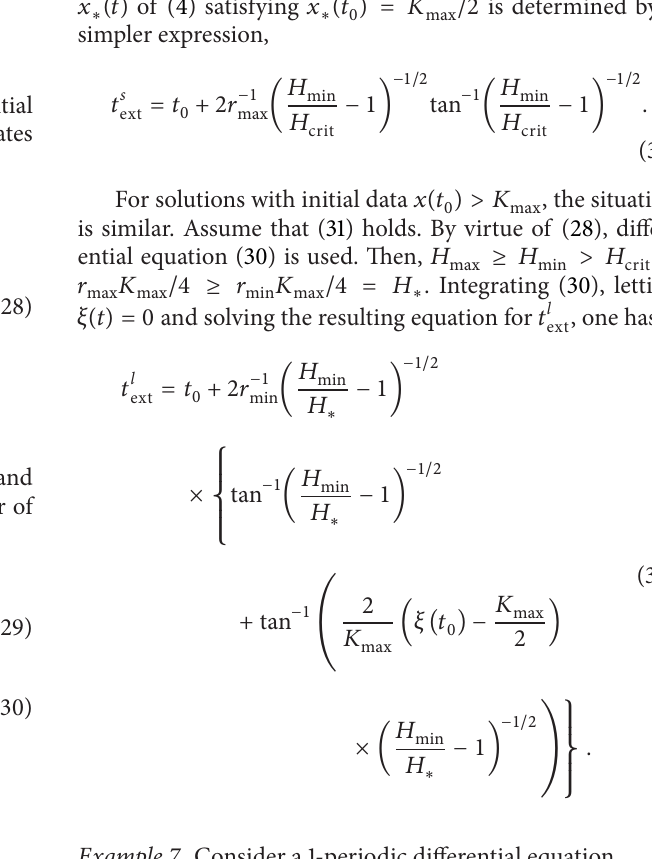
Figure 2: Unstable and stable periodic solutions embraced by upper and lower